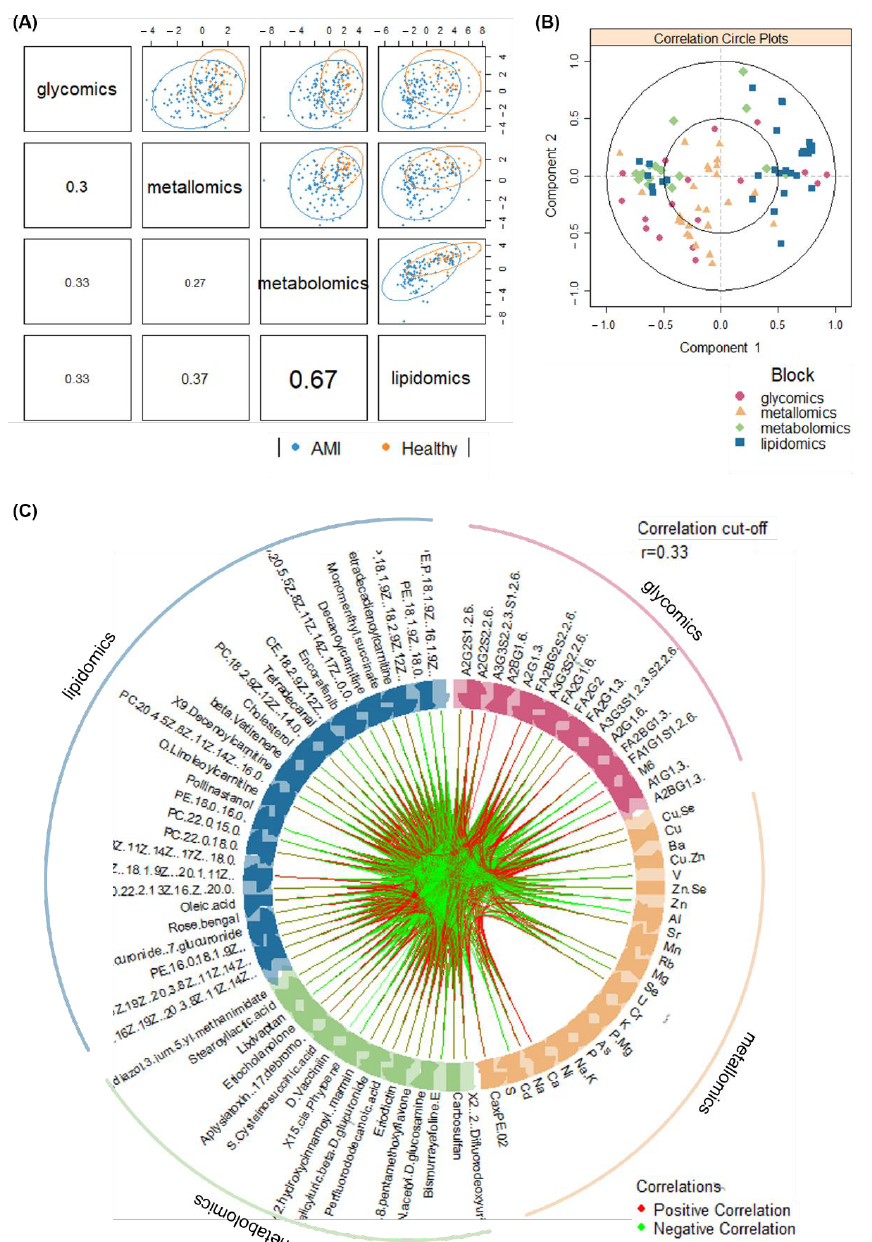
Figure 3. Visualisation of correlations amongst omics datasets via ( A ) sample scatterplot displaying the first component in each omics block (upper diagonal) and Pearson correlation between each component (lower diagonal), ( B ) correlation circle plot representing feature contributions from each omics block, and ( C ) circos plot showing the correlations ( r > 0.33) between omics features as indicated by the red (positive correlation) and green (negative correlation) links.